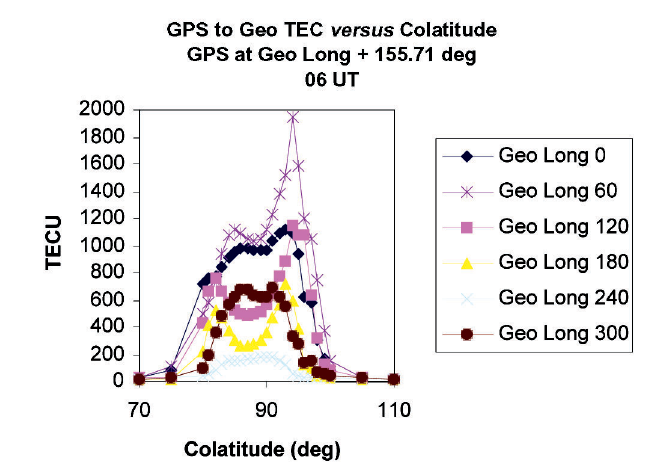
Fig. 18.19. TEC versus colatitude for ray-path from GPS satellite to Geostationary